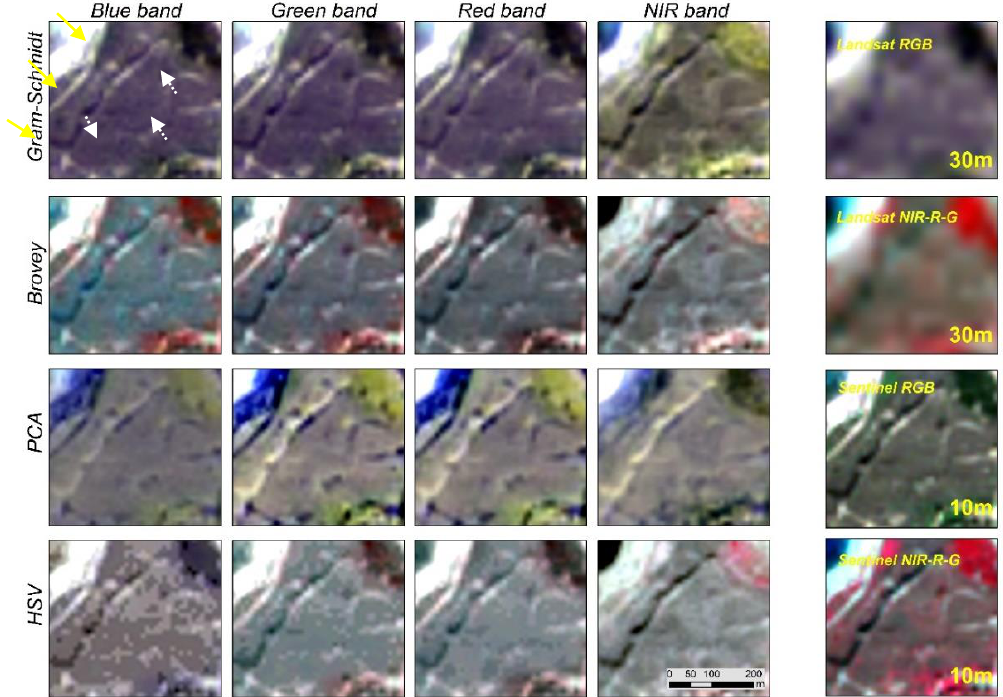
Figure 4. Fusion results of the whole archaeological site of “Nea Paphos” (area b, Figure 1) using the four di ff erent pansharpening methods (Gram–Schmidt, Brovey, PCA, and HSV, at the first to fourth row, respectively) based on the di ff erent Sentinel 2 (10 m) spectral bands used as the panchromatic image (columns). The last column indicates the original 30 m Landsat 8 and Sentinel 2 10 m pixel resolution images at the red, green, and blue (RGB), and near-infrared green and blue (NIR-R-G) pseudo composites. The standing defensive wall is indicated with yellow arrows, and the archaeological proxies are indicated with white